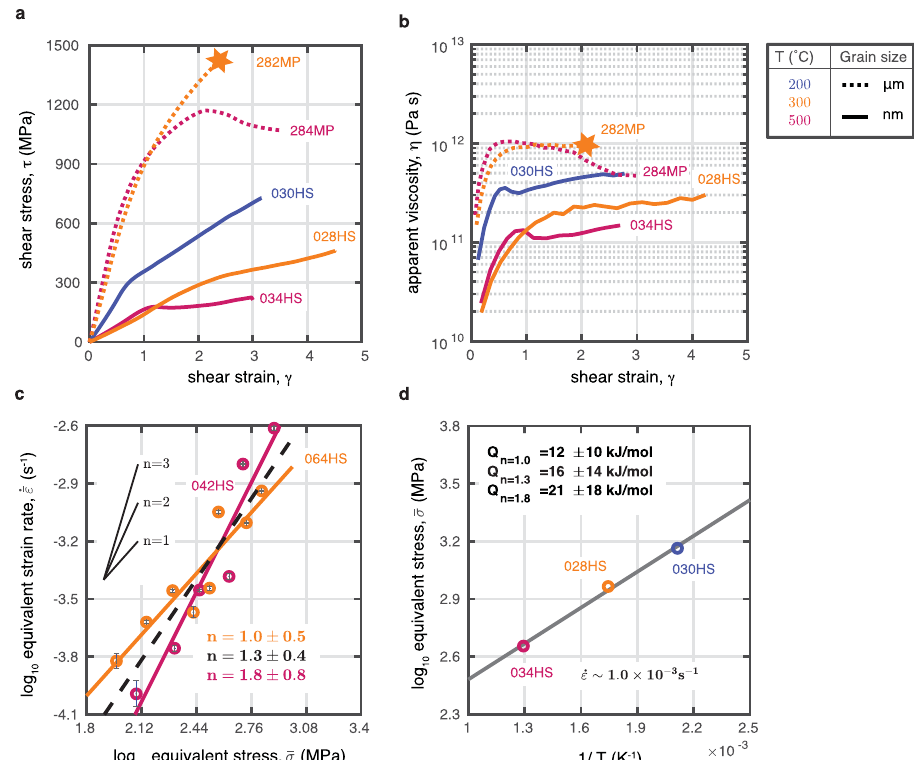
Fig. 1 Mechanical data. a Comparison of the shear strength between nanocrystalline fault rocks, ~0.1 μ m, and microcrystalline fault rocks, ≤ 200 μ m. The nanocrystalline fault rocks are about 1 GPa weaker than the microcrystalline ones. b Nanocrystalline fault rocks have about an order of magnitude lower apparent viscosity than the microcrystalline fault rocks at same T. c Determination of the stress exponent, n = 1.3 ± 0.4. The blue error bars on the plot represent the standard deviation of measurements. The stress exponent is estimated by fi tting to data from both experiments, given that the activation energy of the material is low . d Arrhenius plot determining the activation energy using the constant-displacement-rate experiments. For details of conversion from shear to equivalent stresses and strains see the “ Methods ”